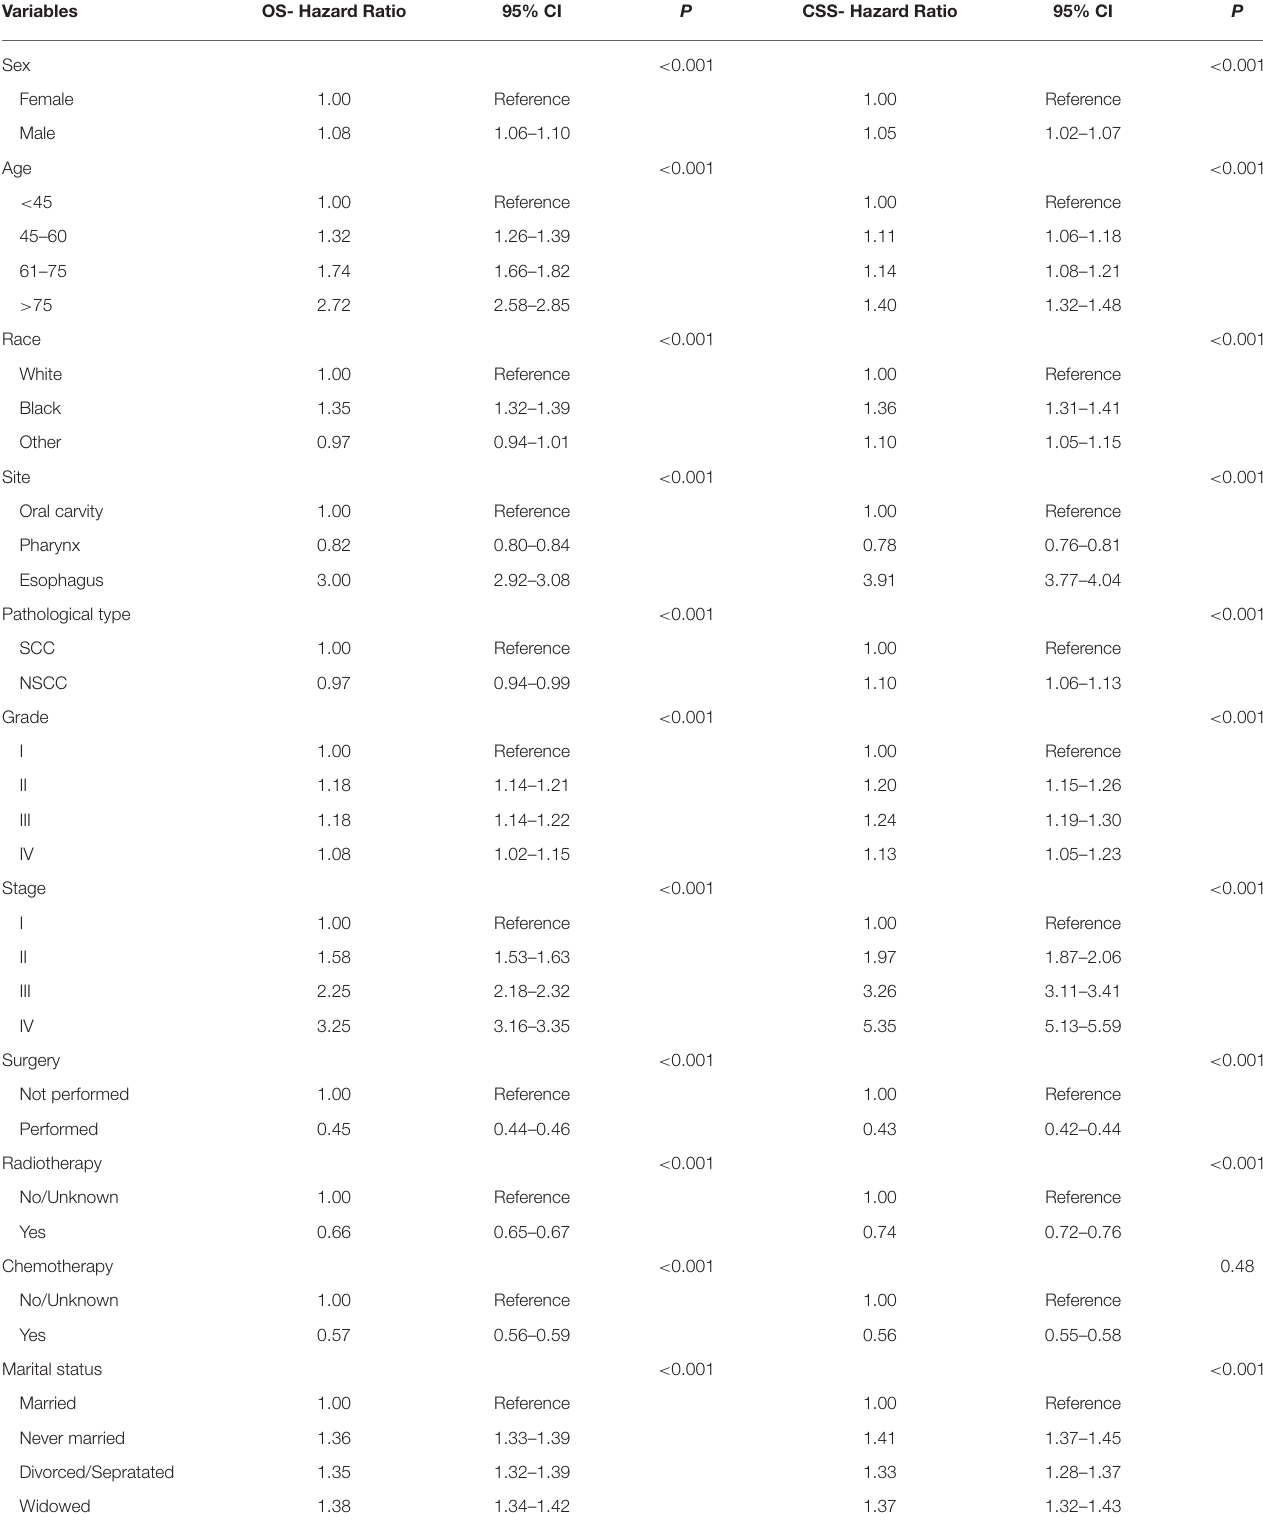
TABLE 3 | Multivariate Cox analyses of prognostic factors of